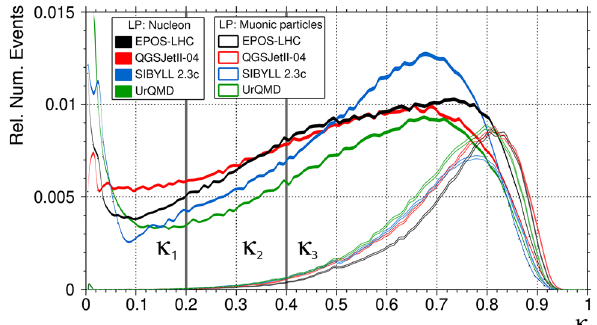
Fig. 4 Inelasticity distributions for the four studied models, for events initiated by the two dominant families; nucleons and muonic particles production of this type of secondary particles. For QGSJetII- 04 the muon production at short distances (r (cid:2) 200 m) is approximately three times larger than for the other